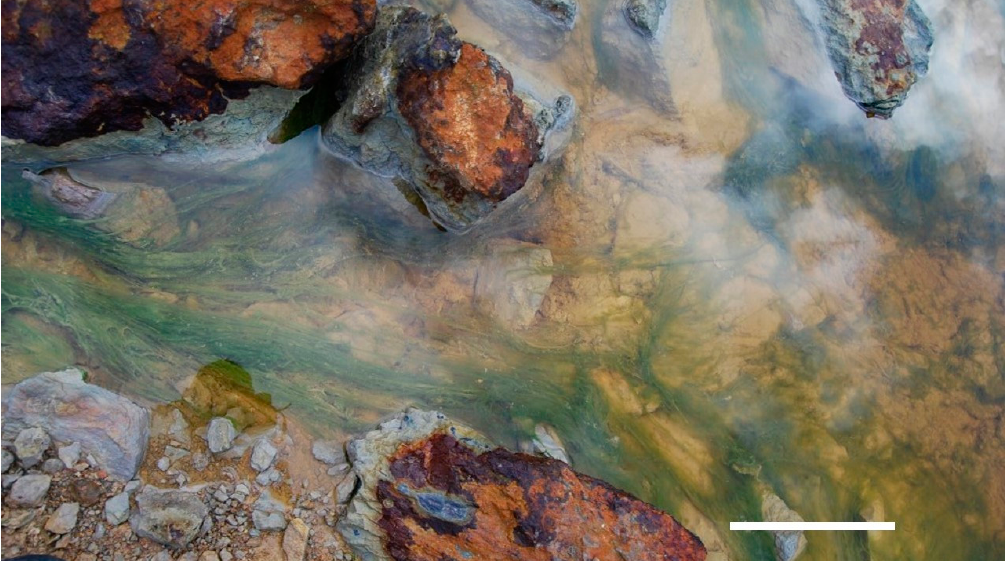
Figure 1. Macroscopic eukaryotic filamentous growth in the sampling site PM5, Parys Mt, UK. Scale bar, 0.1 m.